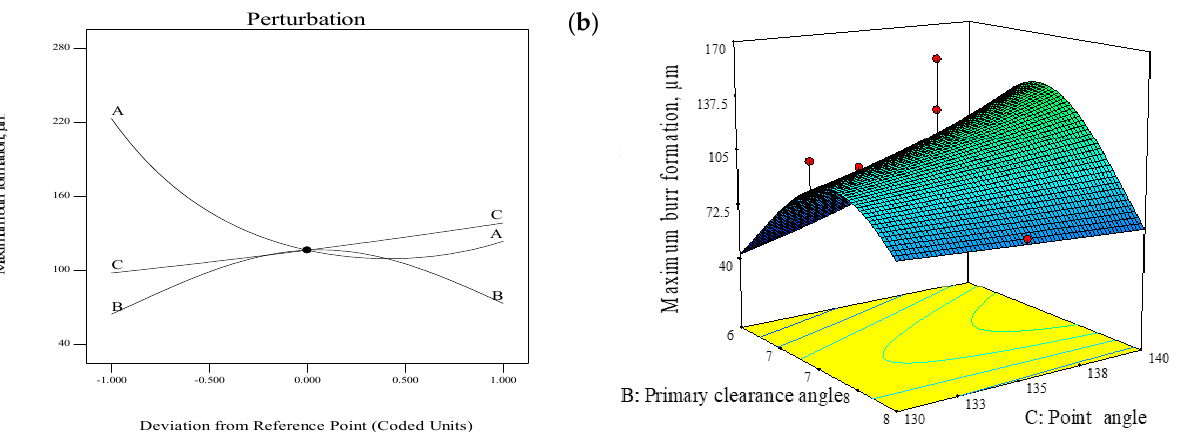
Figure 16. ( a ) Perturbation plot and ( b ) 3D response surface for exit burr height at Al7075 − T6. A, chisel edge angle; B, primary clearance angle; C, point angle.